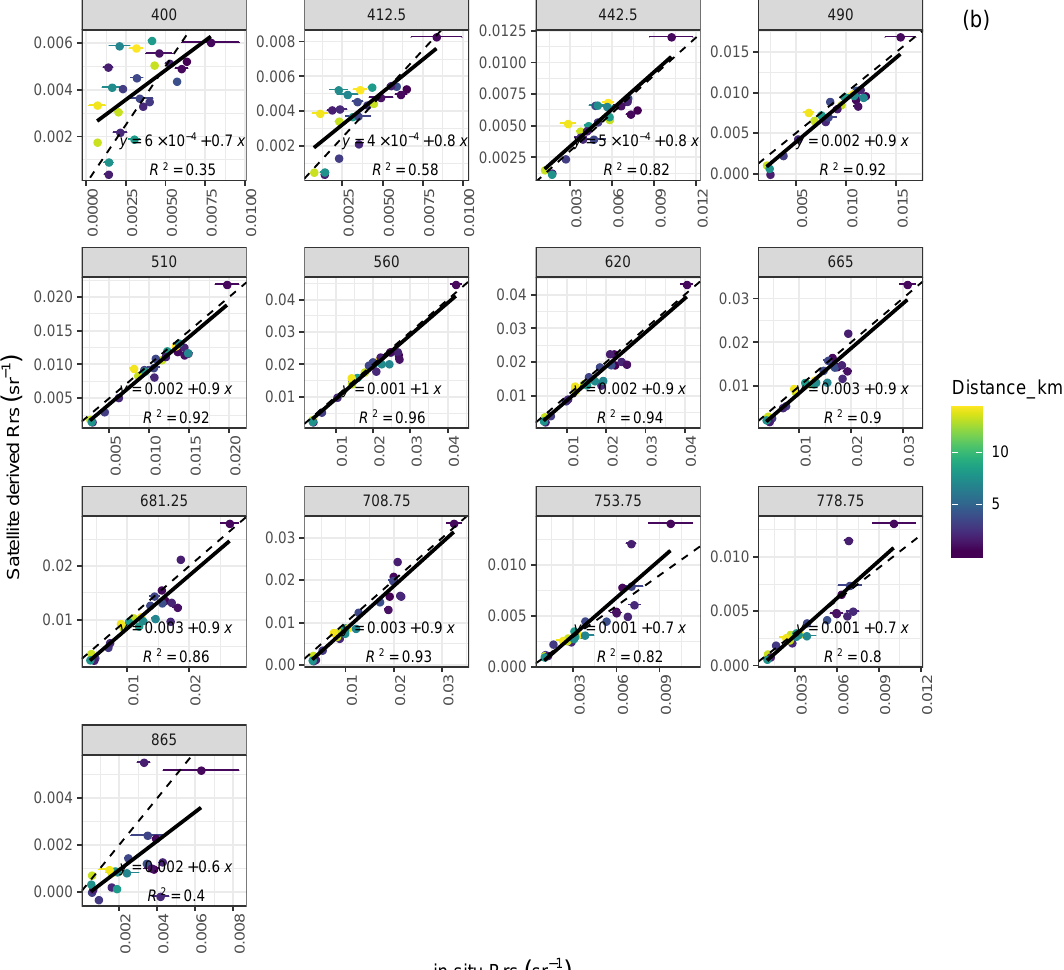
Figure A2. Correlation between in situ measured ( x -axis) vs. POLYMER-derived rho ( y -axis) on OLCI bands. Upper figure ( a ) shows validation results on all data and lower ( b ) after filtering the in situ data based on the 5% criteria at least in one band. For each match-up point, the color shows the distance from the